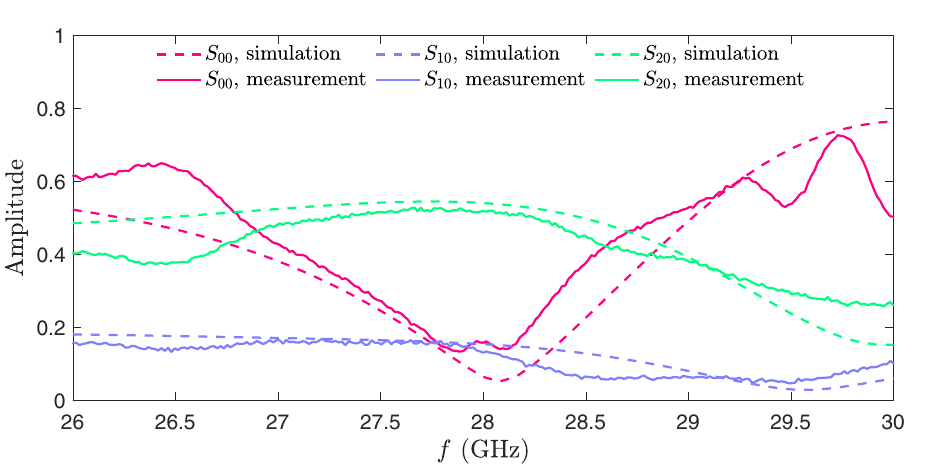
Figure 9. Reflection and transmission coefficients as functions of frequency carried out by simulations and